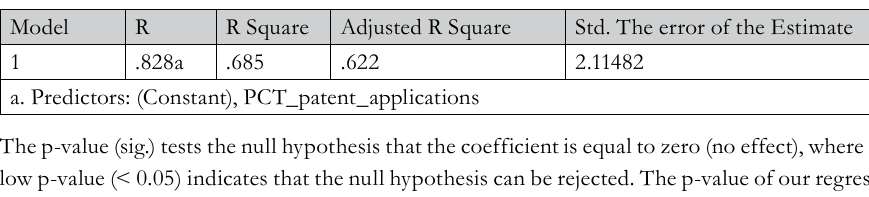
Tab. 3 – Regression model summary – Slovakia. Source: own